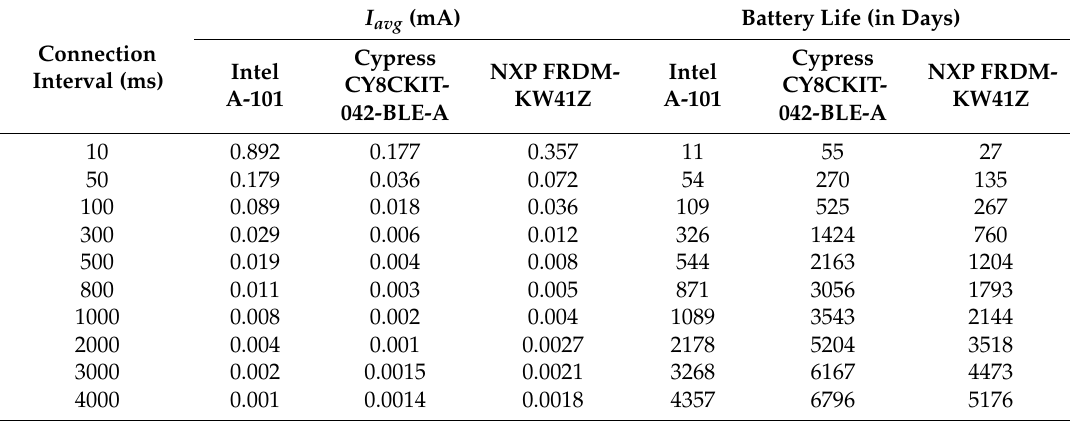
Table 6. Current consumption and expected battery life for each platform configured as CD for different connection intervals.